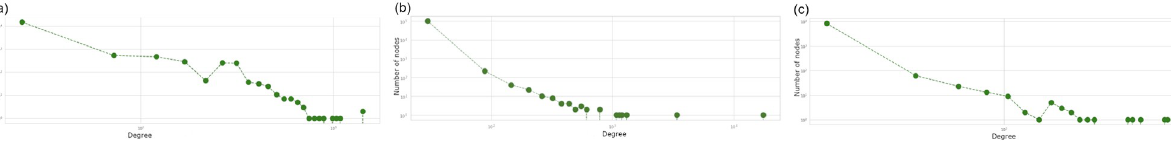
Fig 6. Degree distributions for GitHub, Twitter, and Reddit networks of users who participate in CVE-related discussions. (a) GitHub (b) Twitter (c) Reddit.